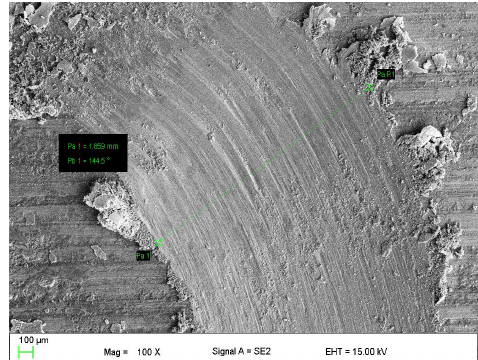
Figure 7. Wear tracks of Cr 3 C 2 –NiCr coatings, magnification 100×.